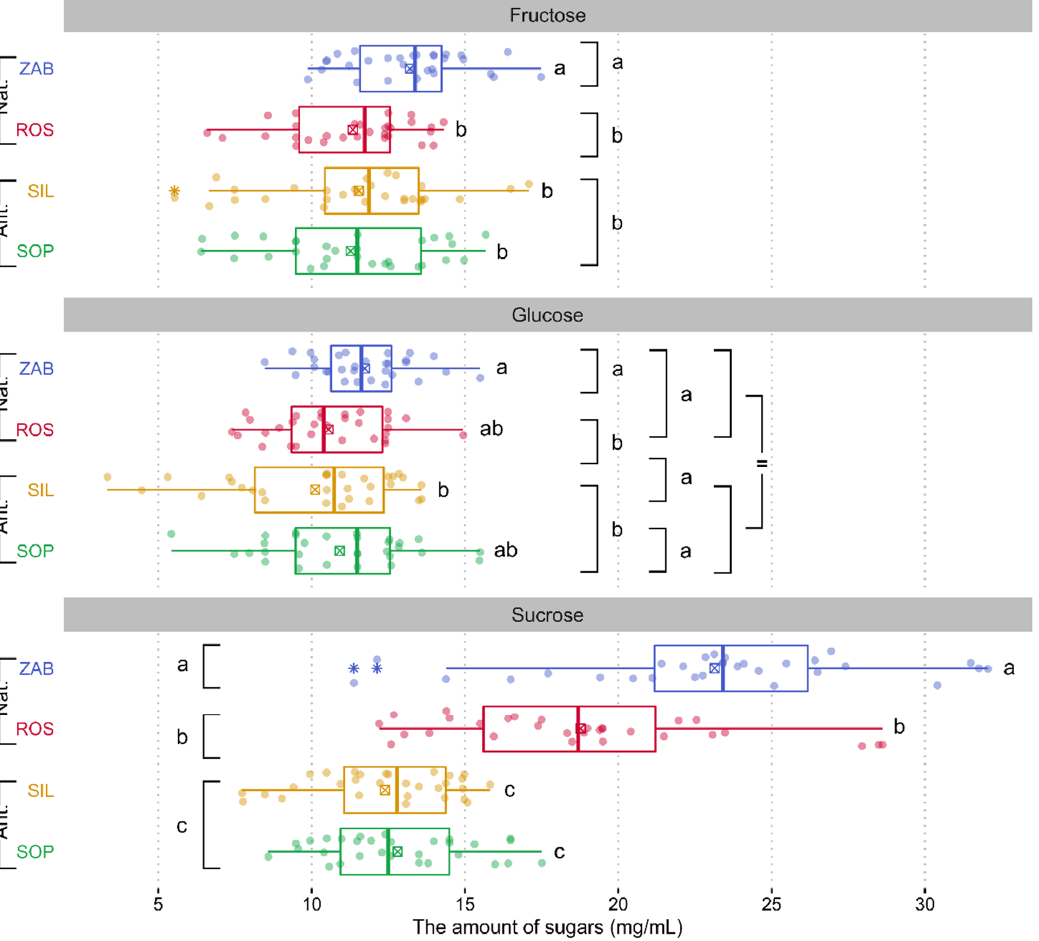
Figure 2. Boxplots of sugar amounts for Epipactis palustris natural (Nat.) and anthropogenic (Ant.) populations. Colored dots are individual samples. The crossed square shows the mean. The lower and upper hinges correspond to the lower (Q 1 ) and upper (Q 3 ) quartiles. Thus, box length shows the interquartile range (IQR). The thicker lines inside the boxes corresponds to the median. The lower whisker extends from the hinge to the smallest value at most Q 1 − 1.5 × IQR of the hinge. The upper whisker extends from the hinge to the largest value no further than Q 3 + 1.5 × IQR. Data beyond the end of the whiskers, indicated with an asterisk symbol, are outliers. Different lowercase letters indicate statistically significant differences according to Tukey’s post-hoc test ( p < 0.05). Symbol “=” means they did not differ significantly. Additional comparisons on the left or right side were shown only when the Nat. or Ant. (or both) populations did not differ